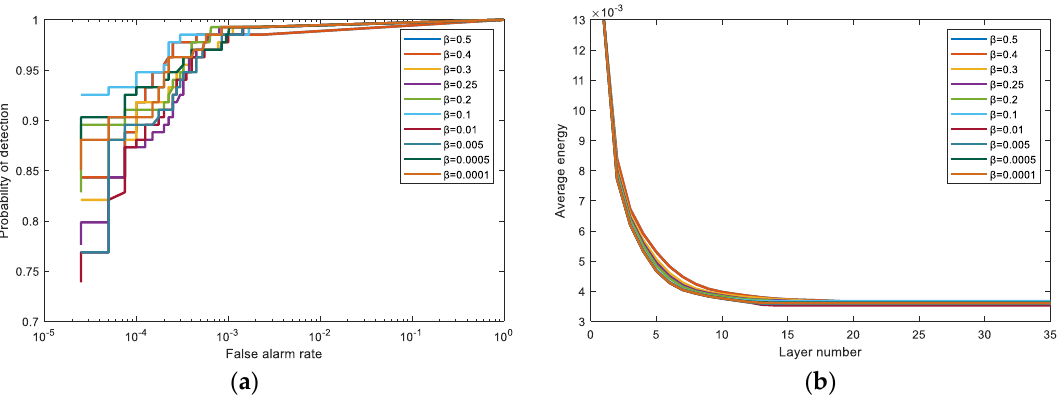
Figure 12. The effects of the different β values on the San Diego Airport data. We choose 10 different values for comparison, including 0.5, 0.4, 0.3, 0.25, 0.2, 0.1, 0.01, 0.005, 0.0005, and 0.0001. ( a ) The ROC curves comparison for different β values. ( b ) The average output energy of different layers for different β values.